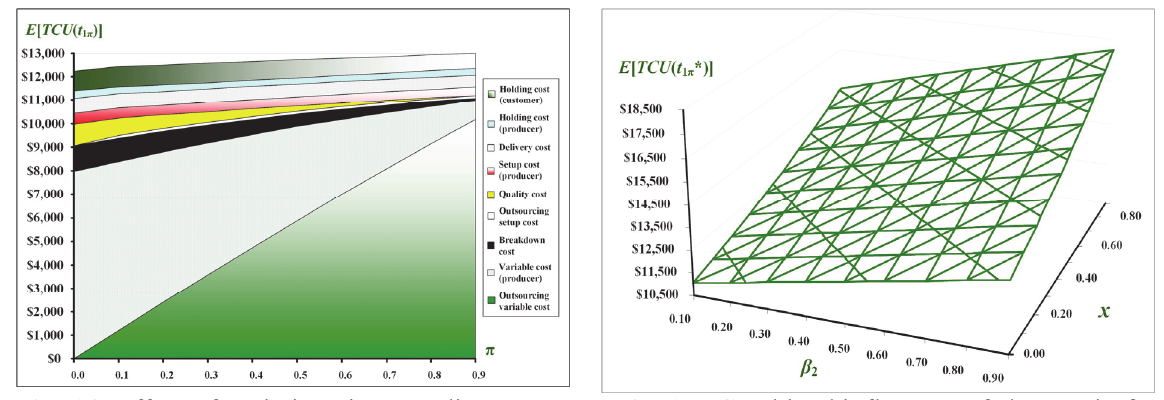
Fig. 15. Combined influences of changes in β 2 and x on E [ TCU ( t 1 π * )]